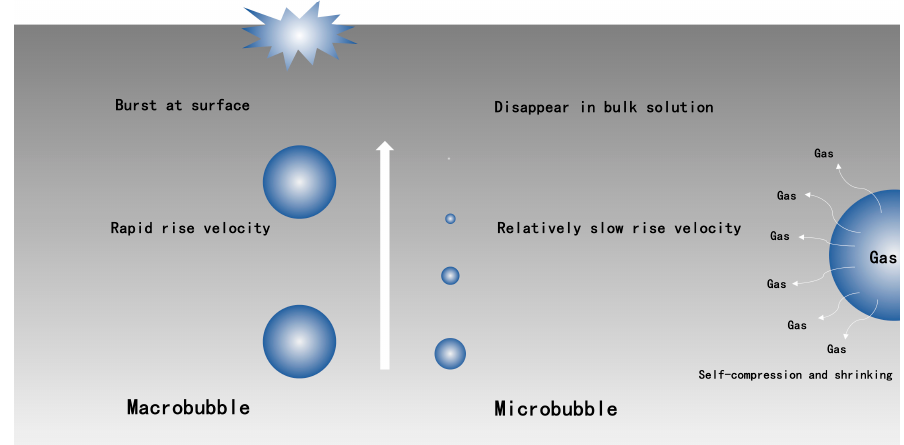
Figure 1. Compared schematic diagram of macrobubble and microbubble (reprinted with permission from (Free-Radical Generation from Collapsing Microbubbles in the Absence of a Dynamic Stimulus, [41]). Copyright (2019) Americam Chemical Society).